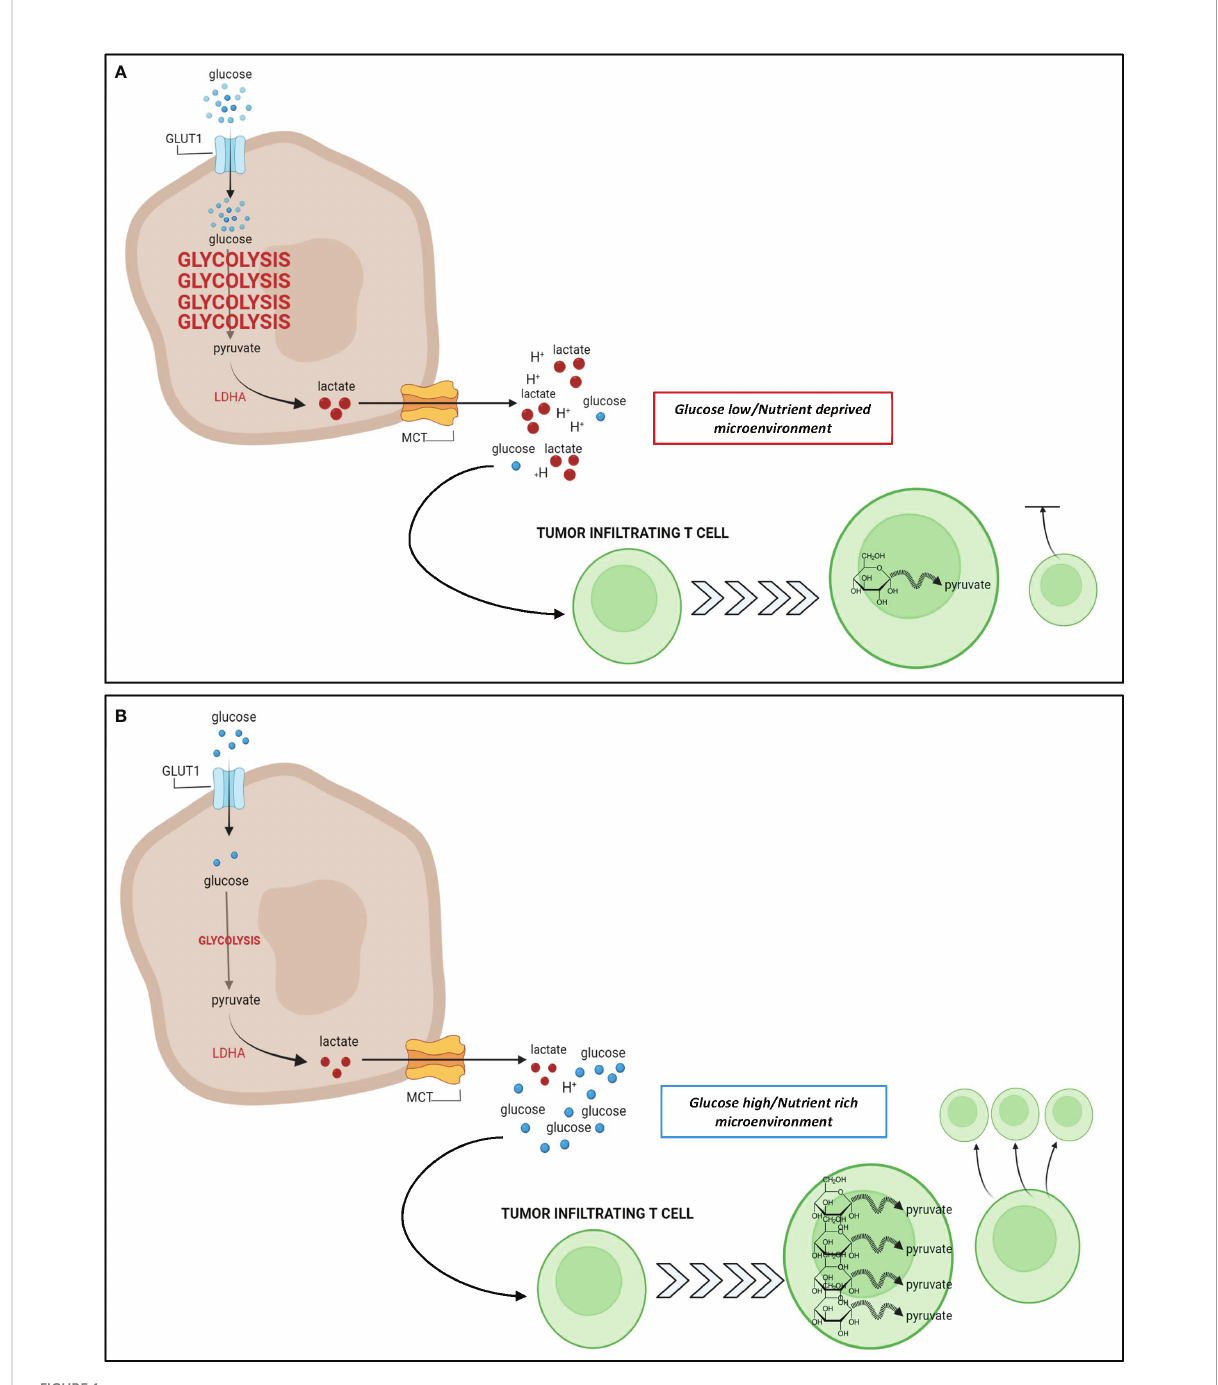
FIGURE 1 Relationship between tumor glycolysis, glucose abundance, and T cell response. (A) : In glycolysis-high tumors such as TNBC, cancer cells take up a large amount of glucose from the extracellular space to fuel their upregulated glycolytic state. The increase in glycolysis generates a large pool of lactate that is excreted from the cancer cell leading to a hostile, acidic, and nutrient deprived TME. Due to the increased glucose uptake by cancer cells, there is a paucity of glucose remaining in the TME for utilization by T cells that in fi ltrate the tumor. These nutrient deprived in fi ltrating T cells are unable to upregulate glycolysis as effectively which results in stunted proliferation and impaired cytotoxic potential. (B) : In glycolysis-low tumors, the cancer cells do not rely heavily on glycolysis for energy metabolism, and their uptake of glucose from the extracellular space is minimal. As a result, there is a higher abundance of glucose and a lower abundance of lactate within the TME, leading to a nutrient rich microenvironment, whereby in fi ltrating T cells can freely take up glucose for their energy needs. Metabolic reprogramming of these T cells favors glycolysis, and contributes to an enhanced effector T cell response. Figure created in